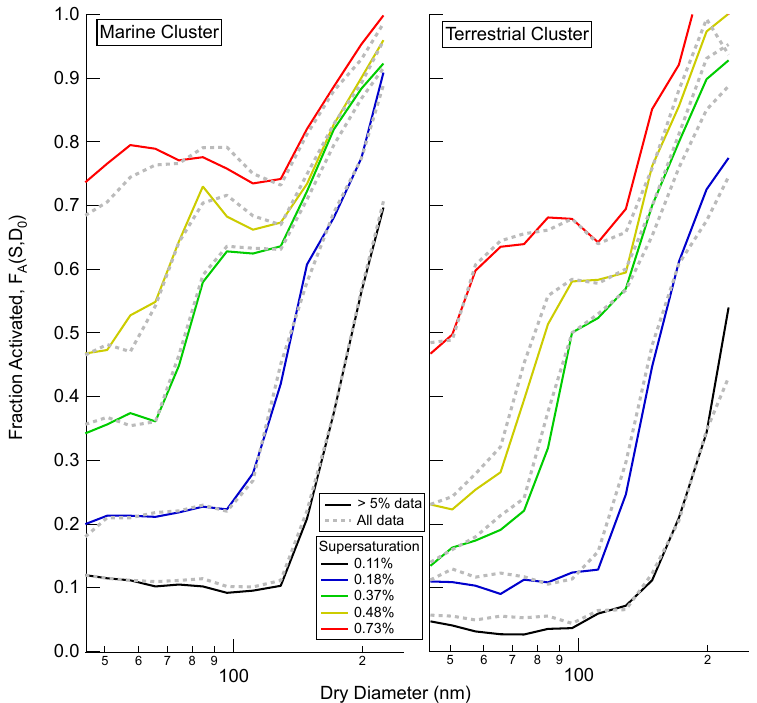
Fig. 3. The fraction activated at each supersaturation as a function of dry diameter, split for the sectorisations Marine and Terrestrial. The grey lines indicate the campaign mean data, and the coloured lines show data from when the HTDMA mean corrected growth factor had smaller than 5% deviation from the peak growth factor